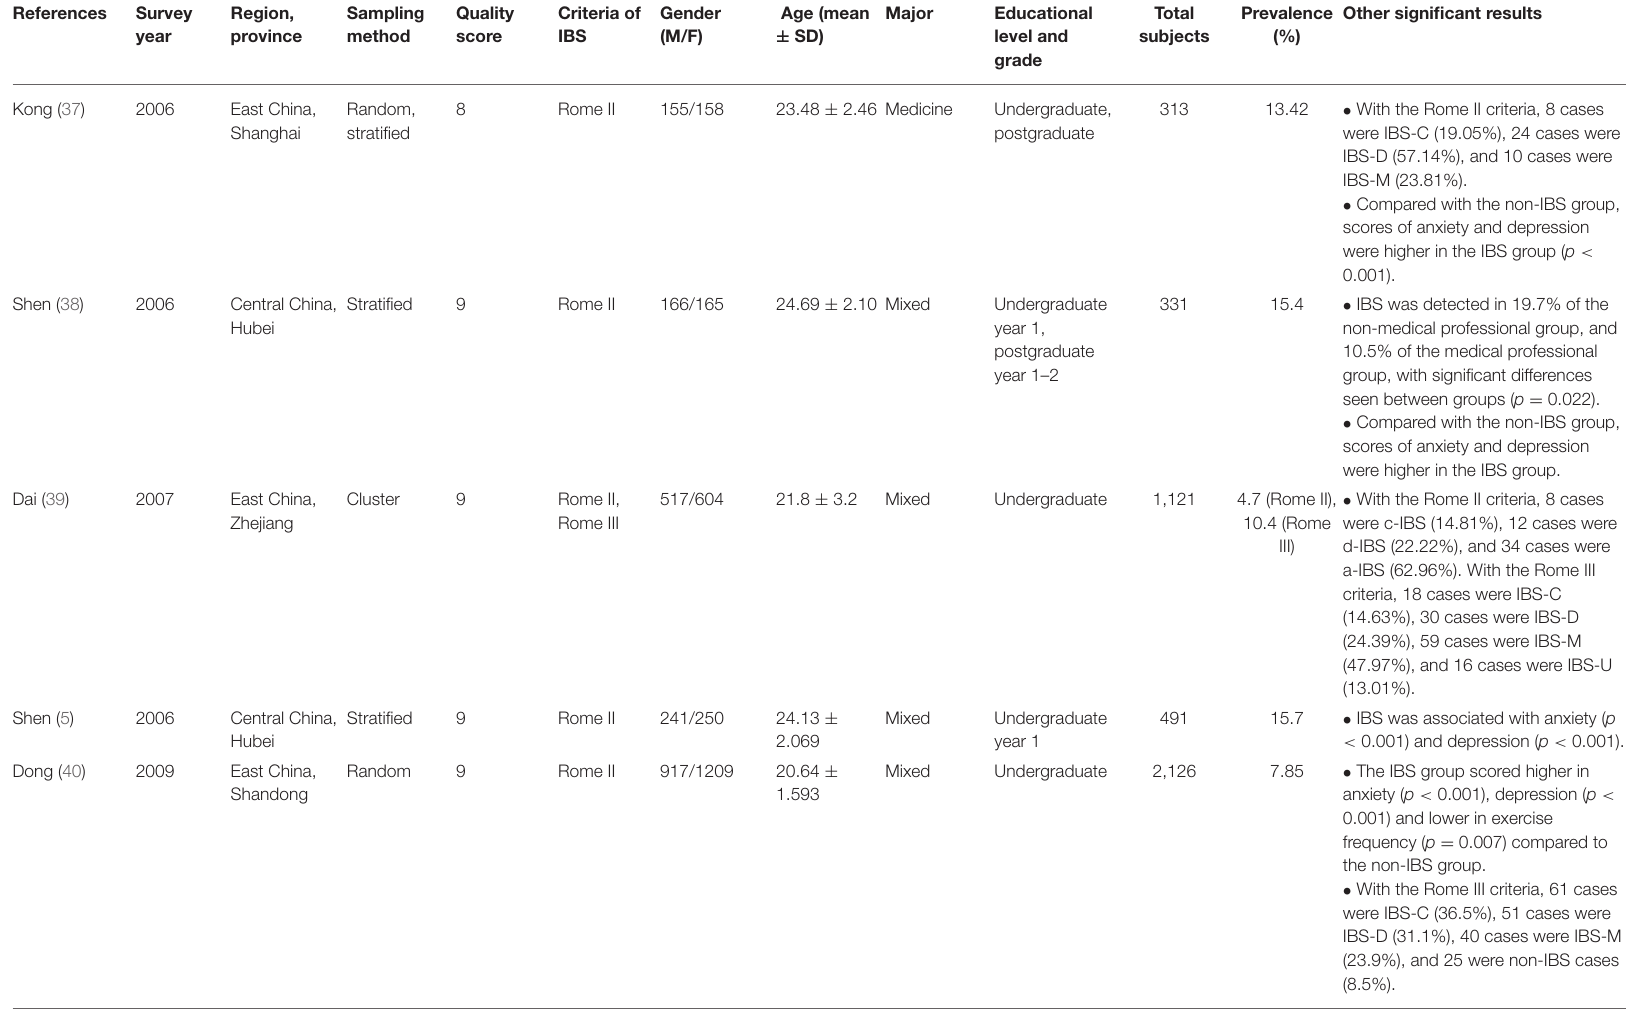
TABLE 1 | Characteristics of included